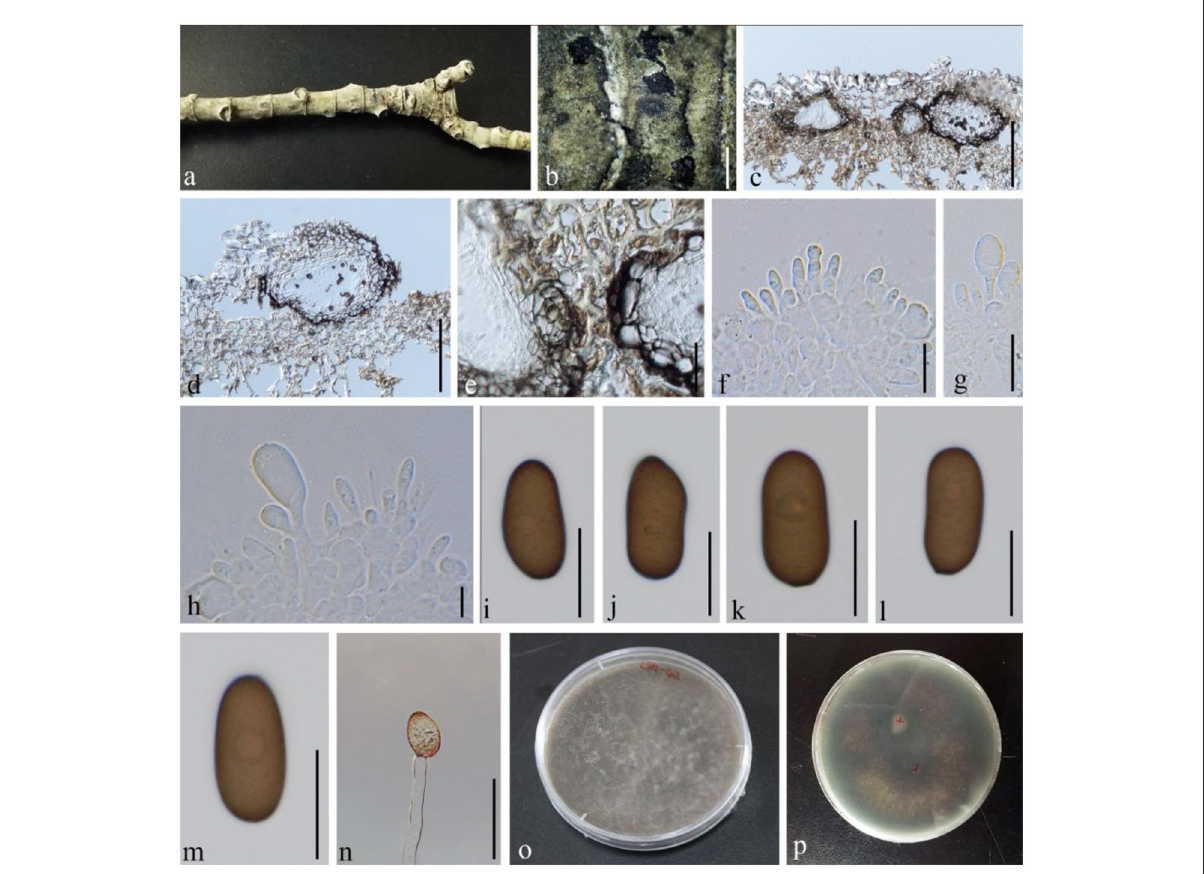
FIGURE6 Diplodia seriata (GMB1383, a new host record). (a) M. grandiflora branch. (b) Appearance of conidiomata on the host. (c,d) Vertical sections of conidiomata. (e) Conidiomata walls. (f–h) Conidia attached to conidiogenous cells. (i–m) Mature conidia. (n) Germinating conidium. (o,p) Cultures on PDA. Scale bars: (b) = 1,000, (c,d) = 150, (e) = 30, and (f–n) = 15 µ